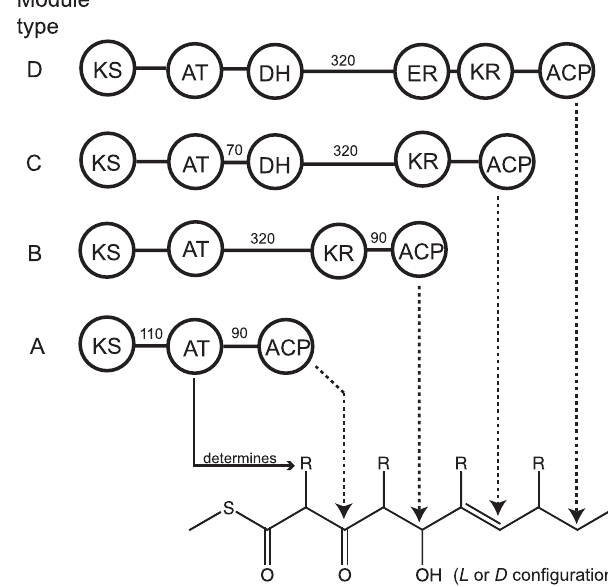
Figure 1. The Different Module Types of Modular PKSs and Their Influence on the Structure of the Polyketide Backbone The numbers written between domains give the typical length of the respective interdomain region in terms of amino acid residues. ER, enoylreductase. DOI: